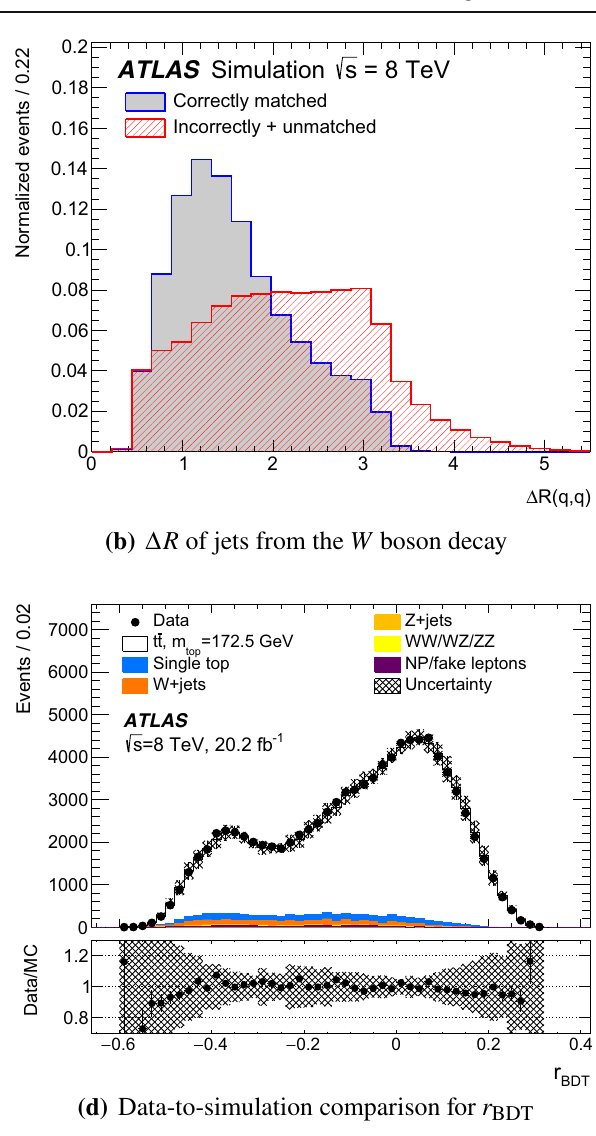
butions peaking at around r BDT = 0 . 1 are for the correctly matched events, the ones to the left are for incorrectly or unmatched events. The ratio figure shows the difference between the number of events in the training and test samples divided by the statistical uncertainty in this difference. Finally, d shows the comparison of the r BDT distributions observed in data and MC simulation. The hatched area includes the uncertainties as detailed in the text. The uncertainty bars correspond to the statistical uncertainties in the